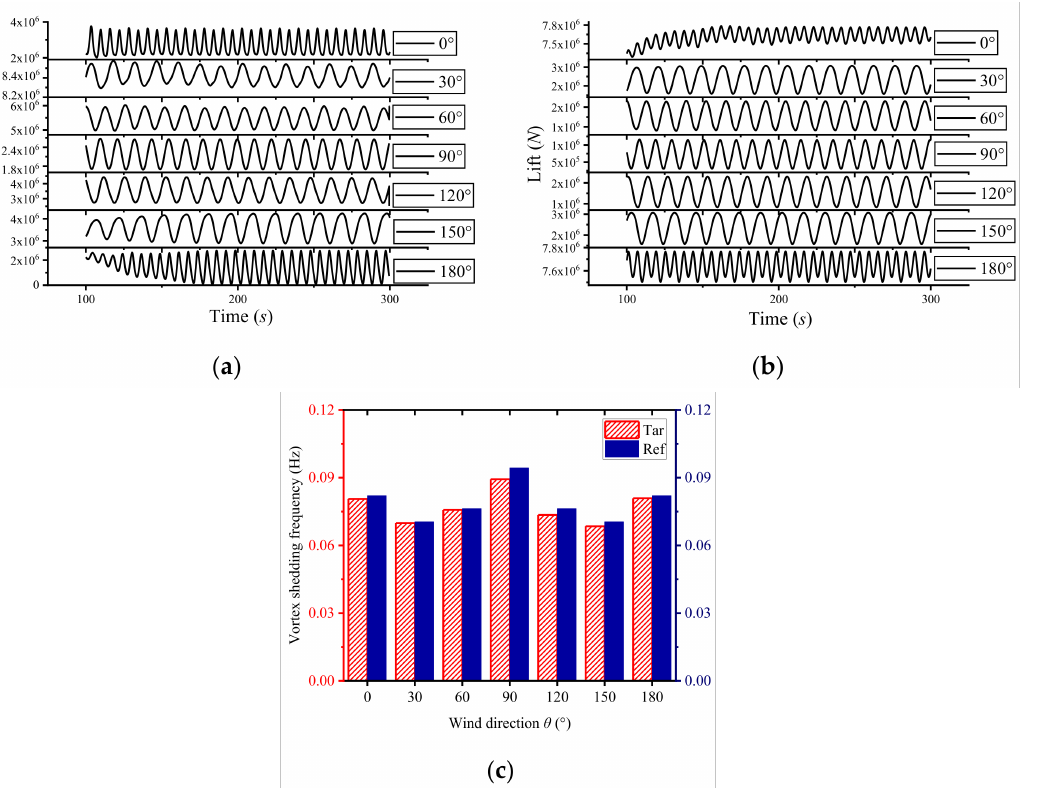
Figure 8. ( a ) Lift time history of the target model; ( b ) Lift time history of the reference model; ( c ) Vortex shedding frequency of the two building models at different wind